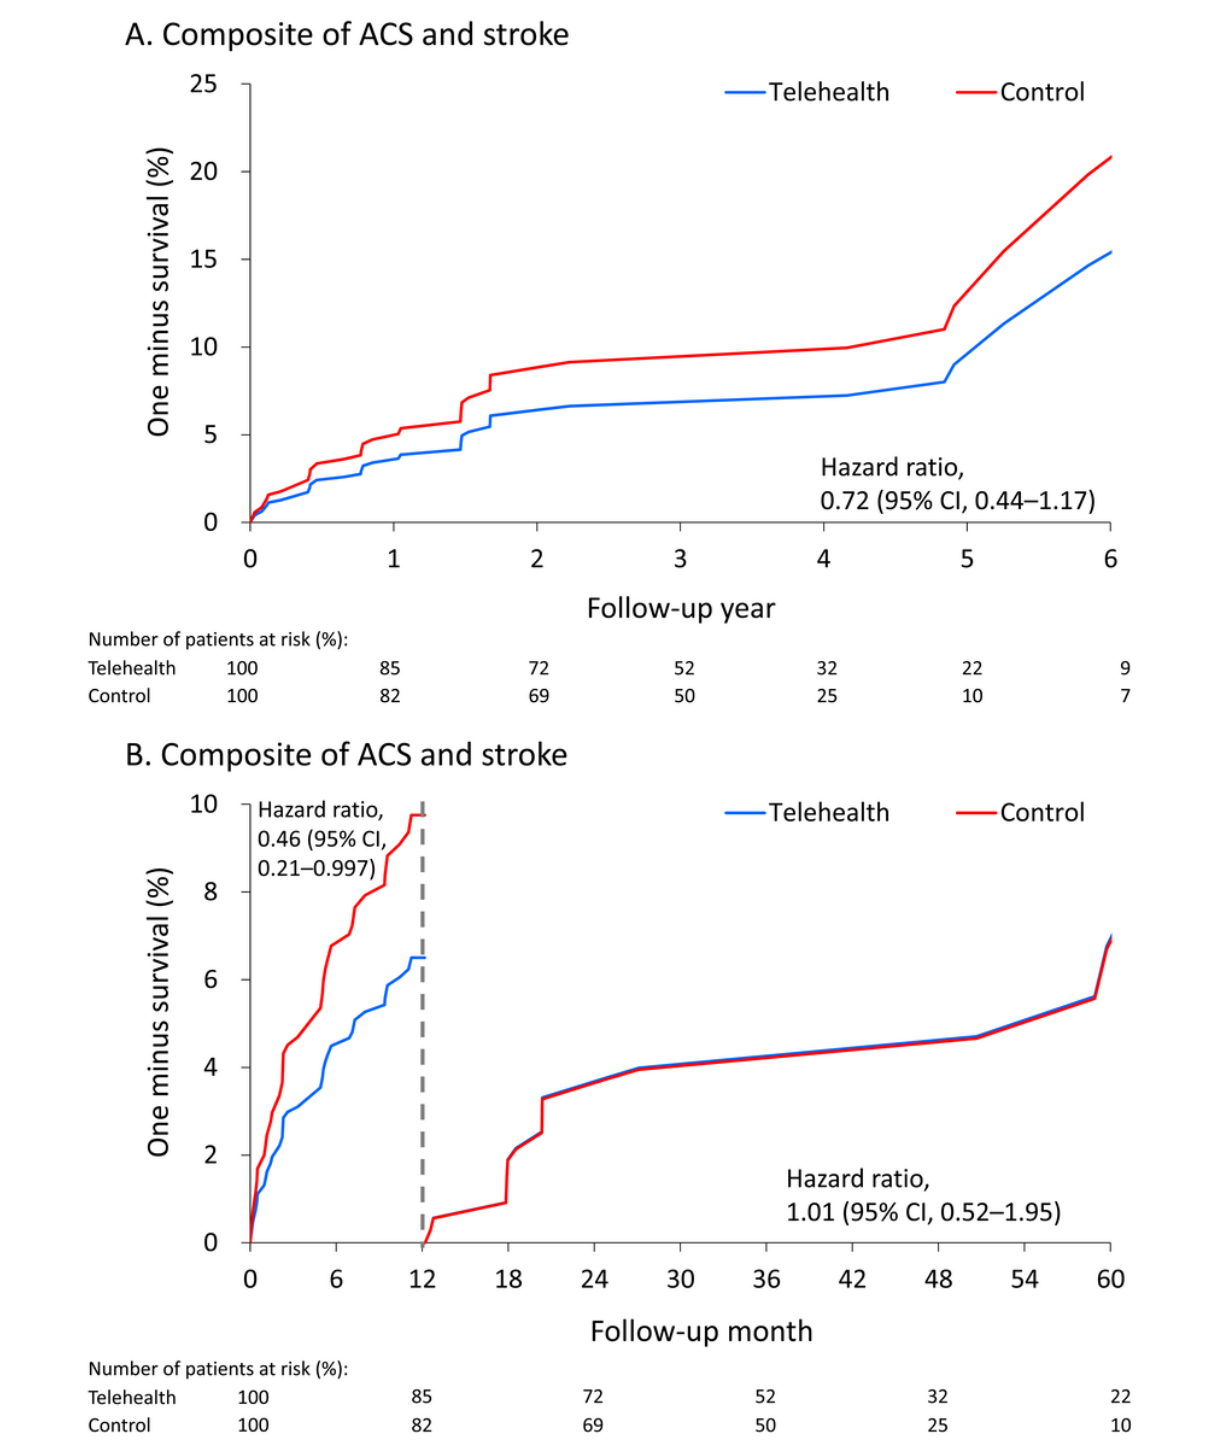
Figure 3. Fitted (predicted) survival curves of composite arterial cardiovascular outcome during the overall follow-up (A) and stratified by